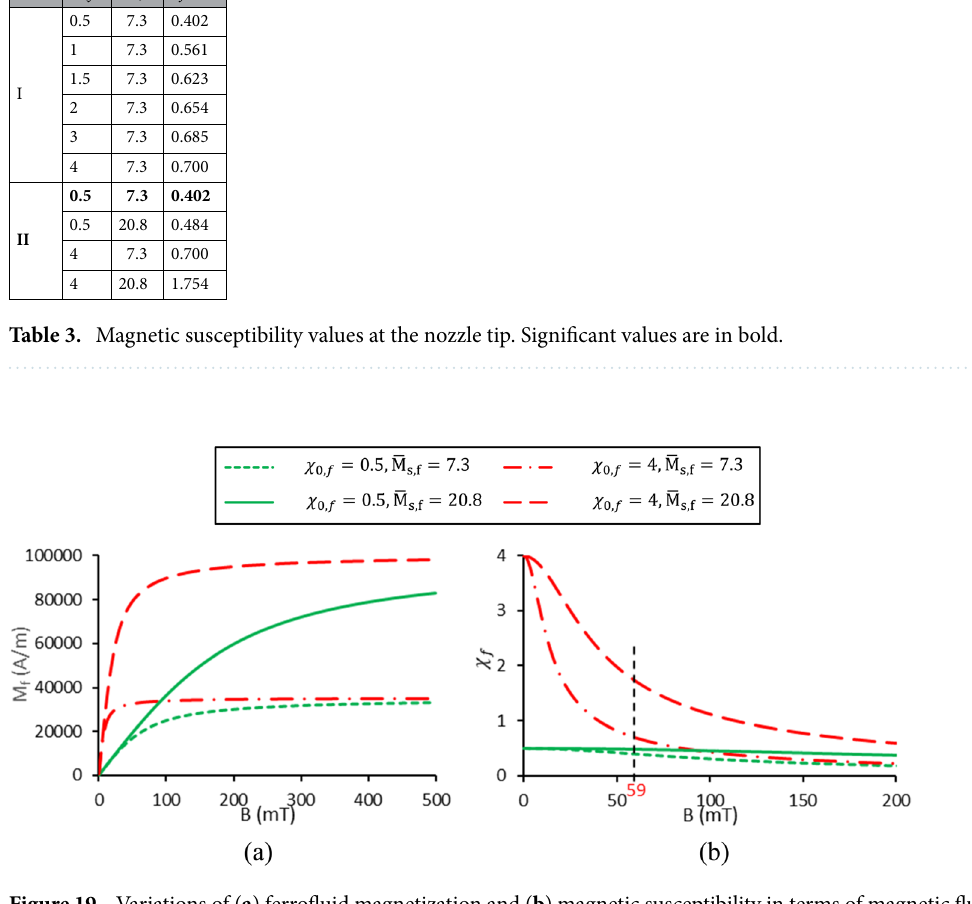
Figure 19. Variations of ( a ) ferrofluid magnetization and ( b ) magnetic susceptibility in terms of magnetic flux density for different initial magnetic sensitivities and dimensionless saturation magnetizations.